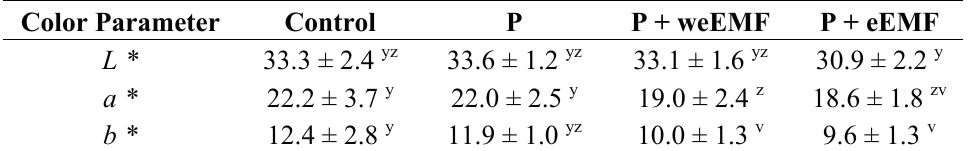
Table 1. Influence of pullulan coating containing meadowsweet flower extract on changes in pepper surface color just after coating. ( L * = lightness; chromaticity parameters a * = redness and b * = yellowness).